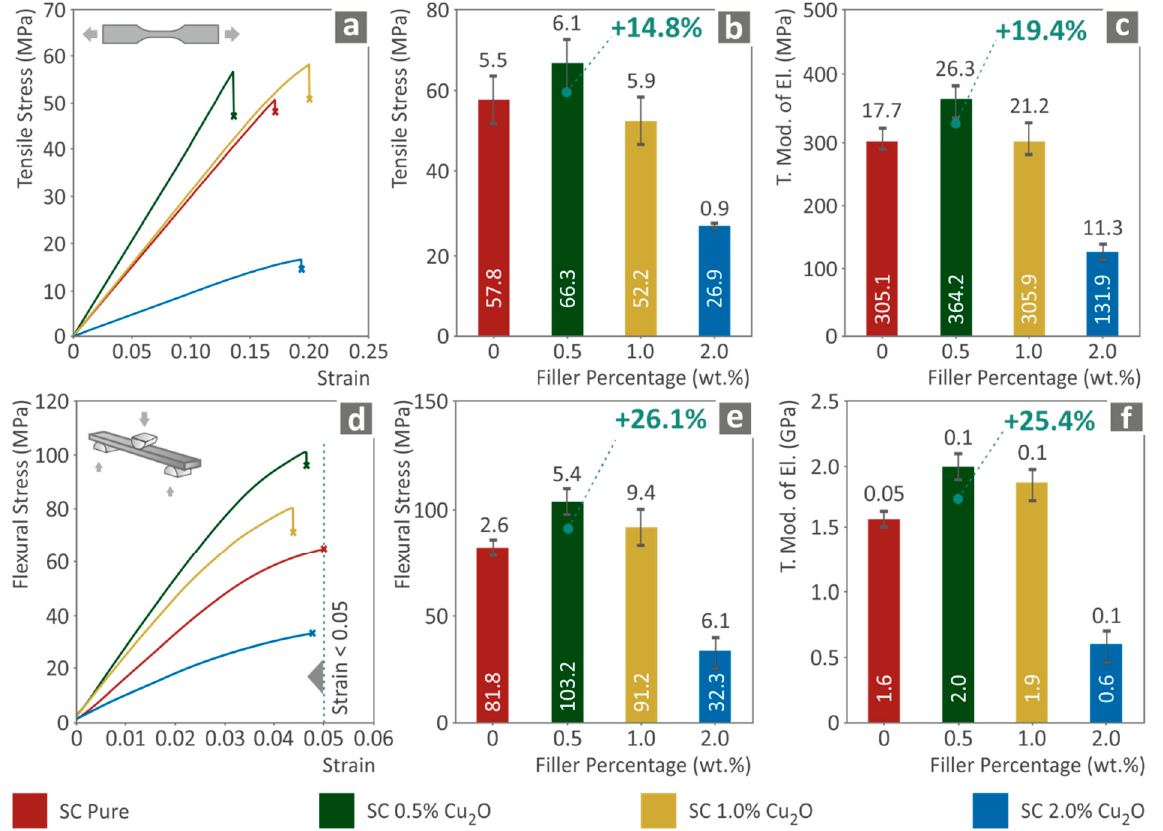
Figure 2. ( a ) Typical tensile stress (MPa) to strain (mm/mm) curve, ( b ) Tensile stress at break (MPa) to filler loading (wt.%), ( c ) tensile elastic modulus (MPa) to filler ratio (wt.%), ( d ) Typical flexural stress (MPa) to strain (mm/mm) curve, ( e ) Flexural stress at break (MPa) or 5.0% strain -if no break existed- to filler loading (wt.%), ( f ) flexural modulus of elasticity (MPa) to filler ratio (wt.%).